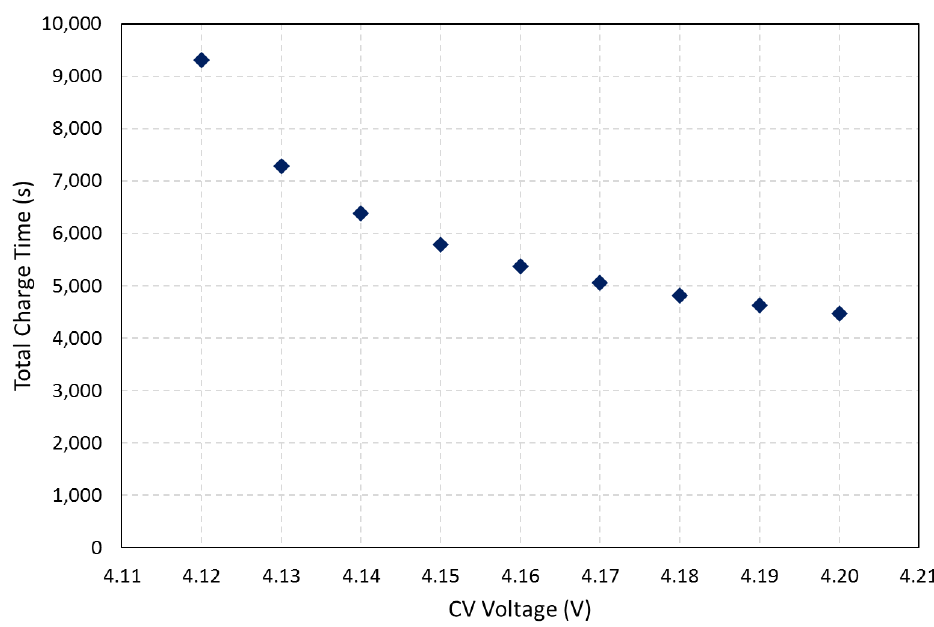
Figure 11. Necessary CV stage time at different cut-off voltage values to reach 90% and 95% SOC with the proposed fast charge method. Both data series are fitted to exponential equations, of which the coefficients are also shown.